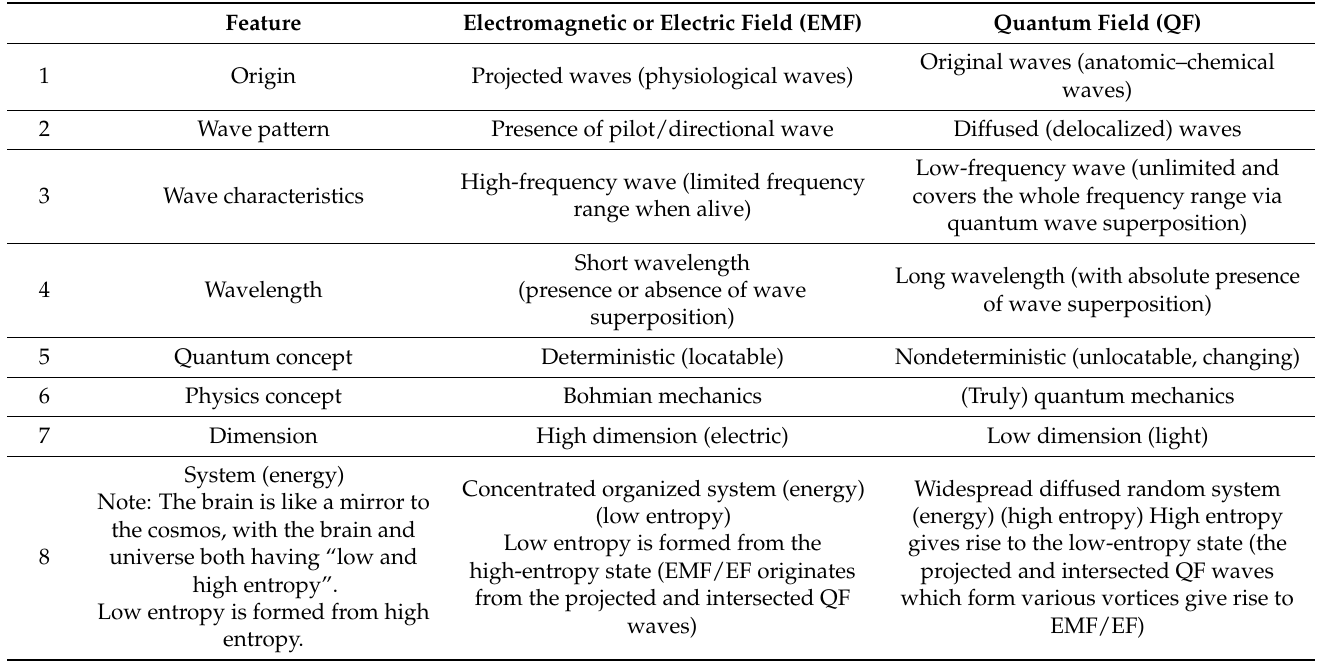
Table 1. General features of the brain electromagnetic field (EF or EMF) and brain quantum field (QF) or brain quantum–light field